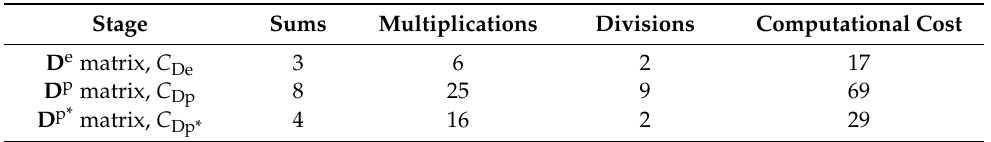
Figure 3. Integration of a computational step using ( a ) a conventional explicit algorithm and ( b ) the precomputational approach. Table 1. Equivalent sum costs of the main stages that conform to a conventional explicit integration algorithm and an algorithm with the proposed